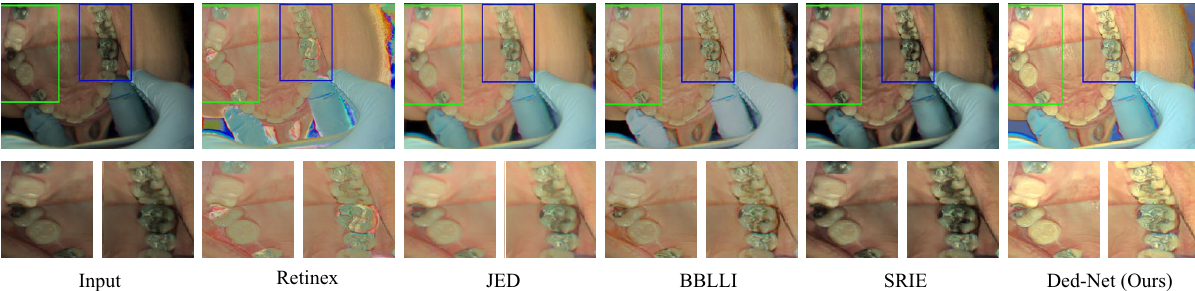
Figure 12. Comparison with Retinex, JED, BBLI, SRIE, and Ded-Net